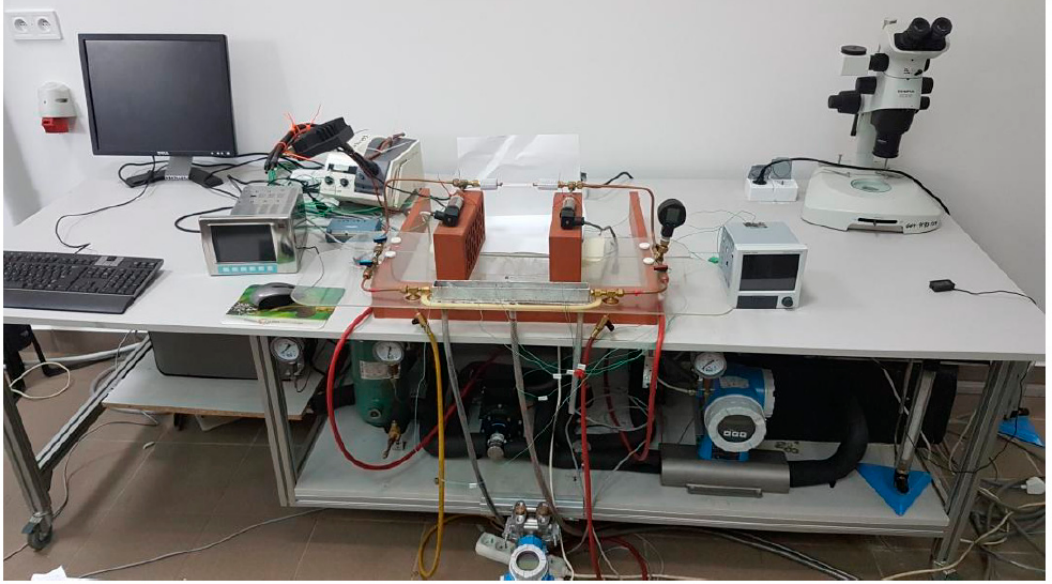
Figure 1. Schematic diagram of the test stand for HFE 7000 refrigerant condensation in minichannels.